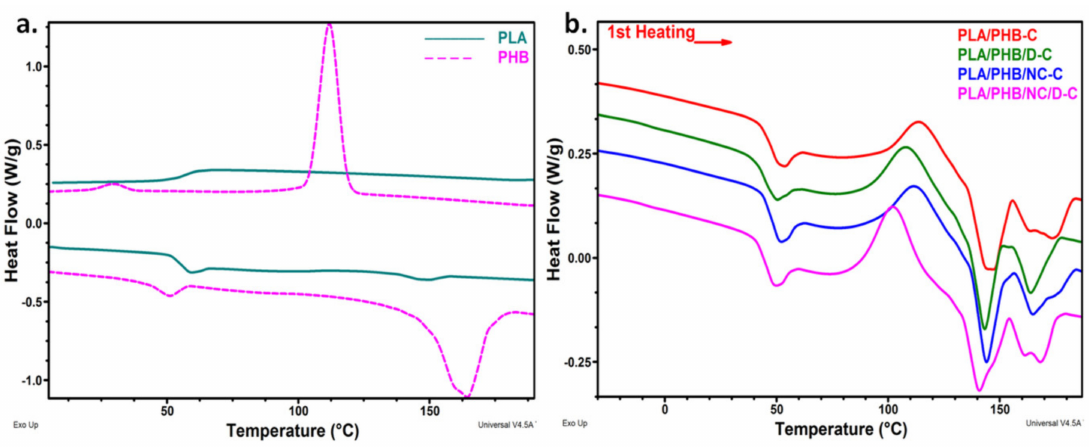
Figure 7. DSC curves of pristine PLA and PHB—first heating and cooling scans ( a ) and that of PLA / PHB blends and nanocomposites—first heating scan ( b